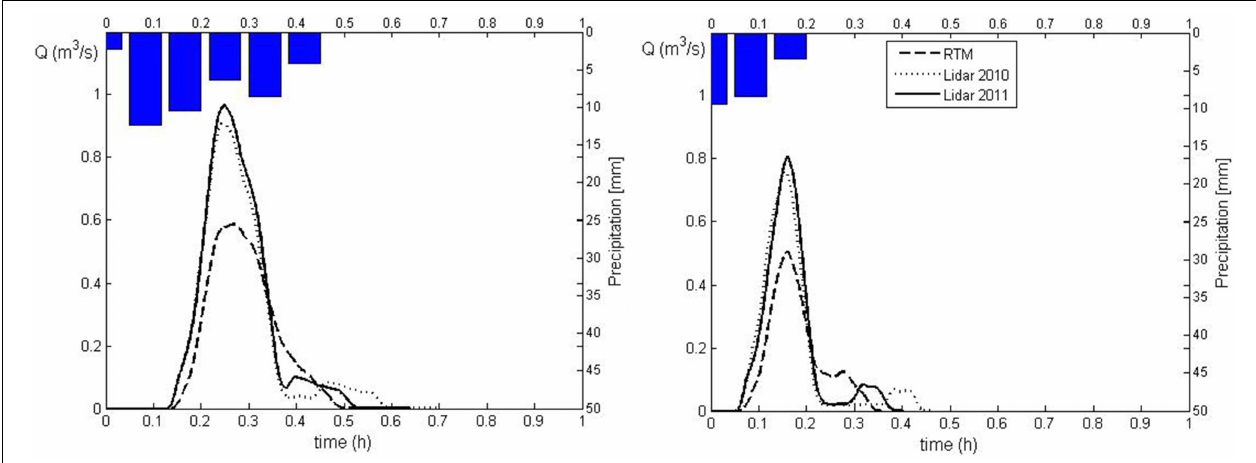
FIGURE 7 | Runoff simulations corresponding to the precipitations that triggered the debris flows occurred July 5, 2006 (left) and August 18, 2011 (right) in Dimai